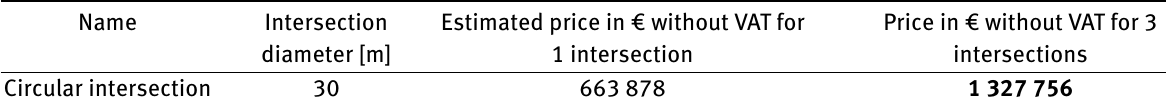
Table 2: The funds needed in the construction of circular intersections Name